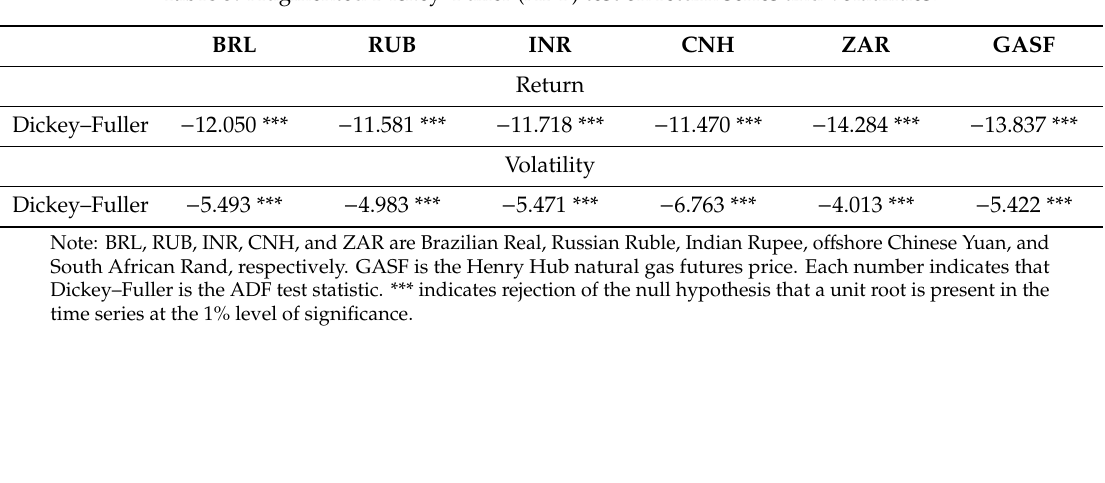
Table 5. Augmented Dickey–Fuller (ADF) test on return series and